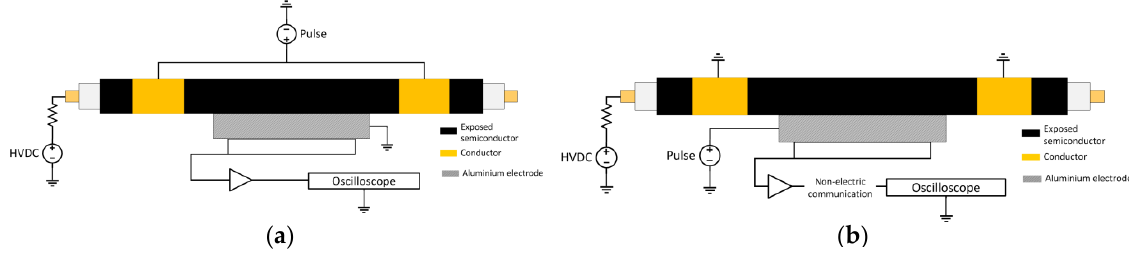
Figure 1. Application of the pulsed voltage. ( a ) Pulse application via the outer screen. ( b ) Pulse application via the test cell.